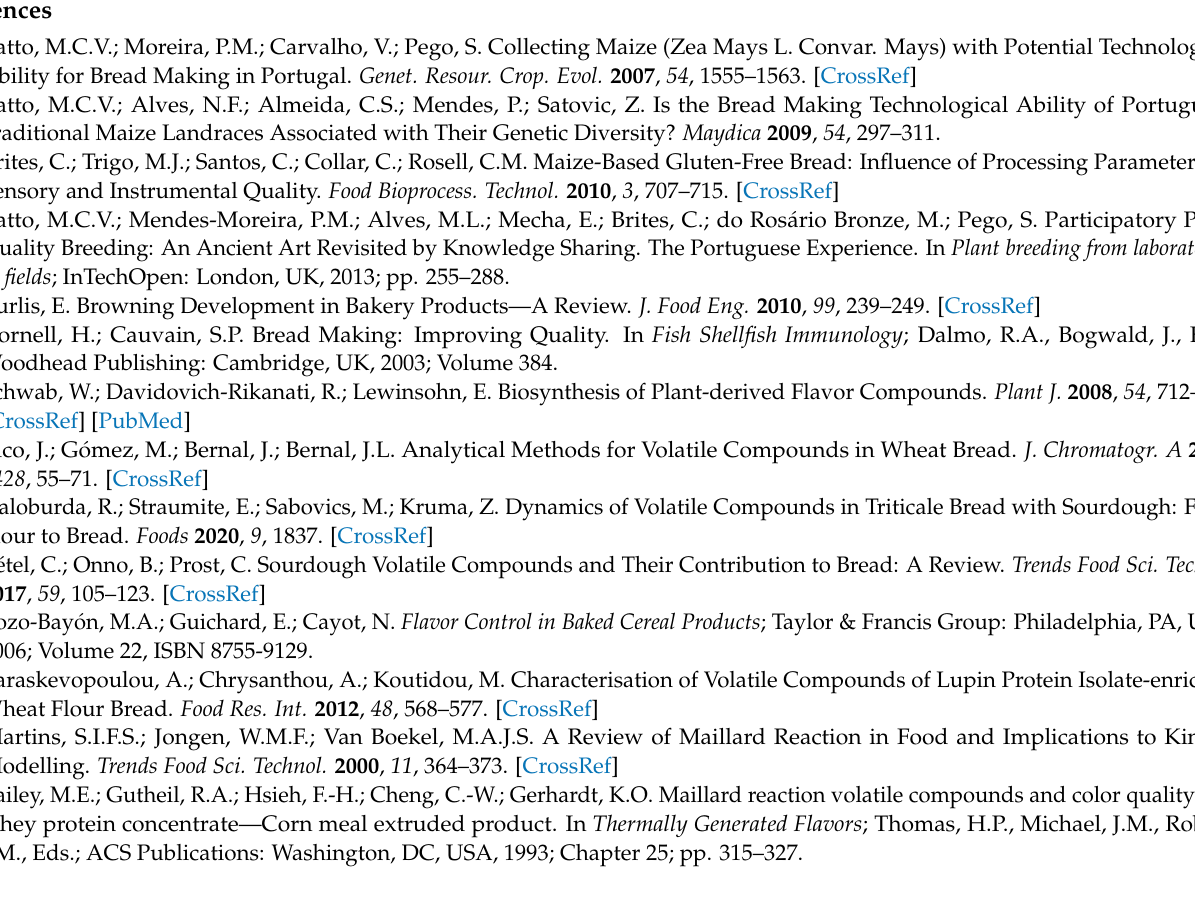
Table S10: Spearman correlation coefficients between broas’ volatile compounds and sensorial analysis scores, Table S11: Spearman correlation coefficients among broas’ sensorial analysis